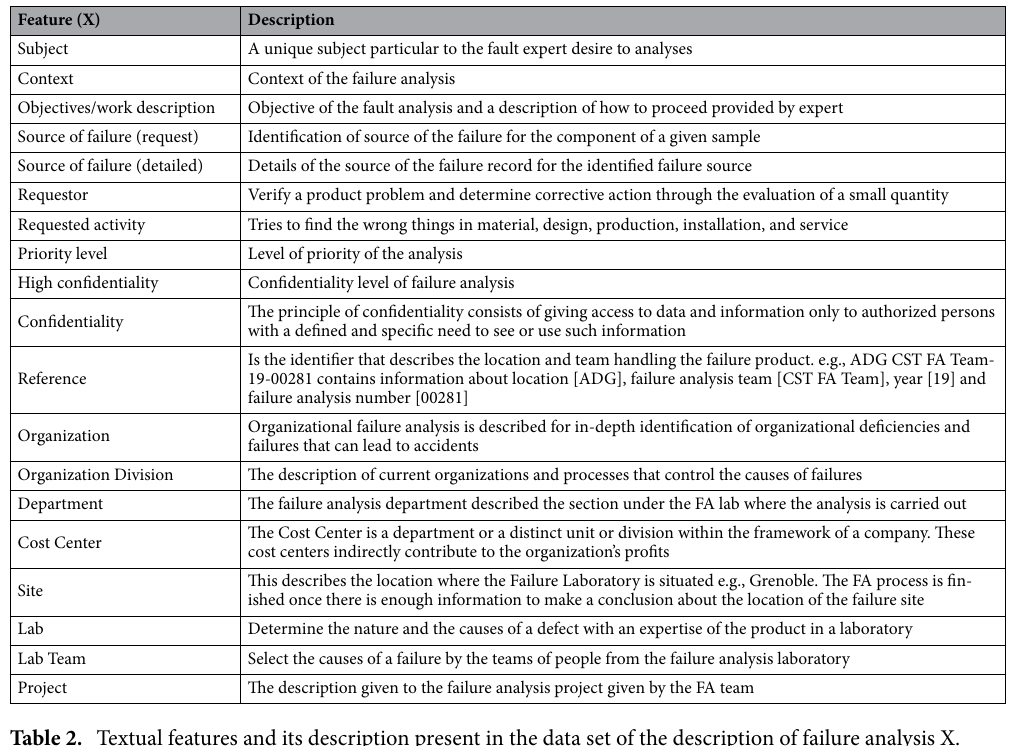
Table 2. Textual features and its description present in the data set of the description of failure analysis